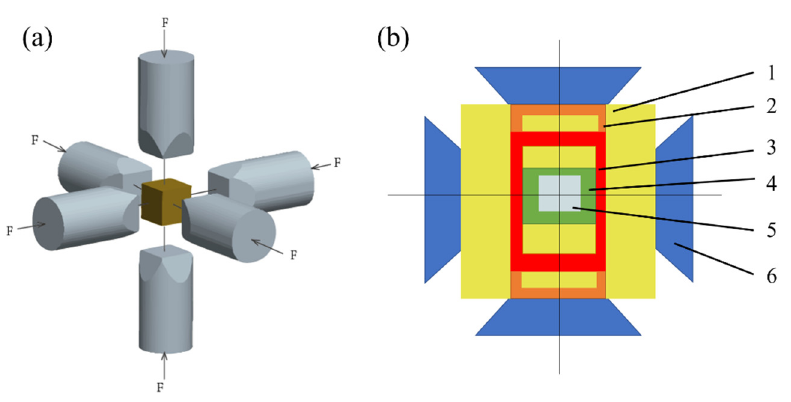
Figure 1. A schematic diagram showing ( a ) high-pressure equipment and ( b ) cell assembly sample for high-pressure synthesis: 1—pyrophillite, 2—conducting ring, 3—graphite crucible, 4—BN (clad), 5—sample, and 6—Top ram.